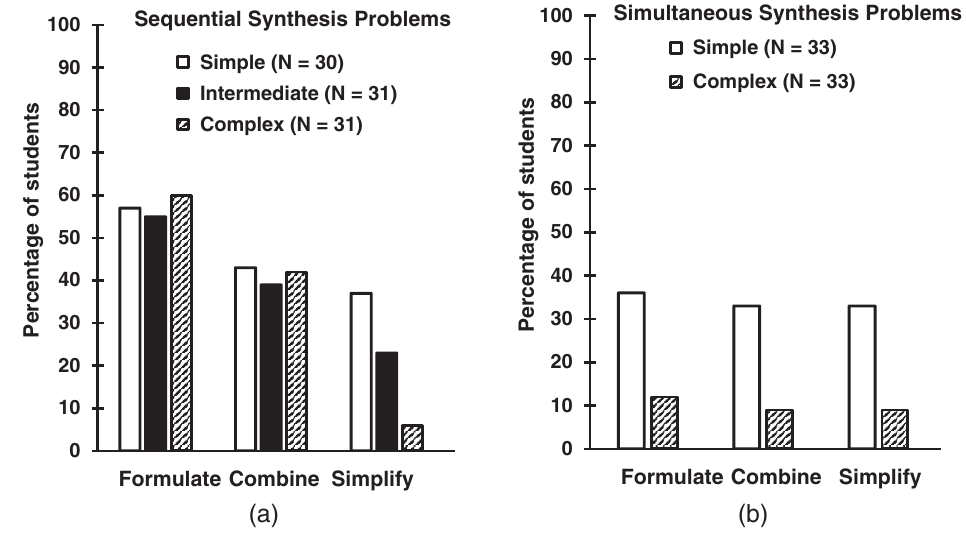
FIG. 6. Mathematical performance on synthesis tasks with varying mathematical complexity: (a) sequential and (b) simultaneous synthesis